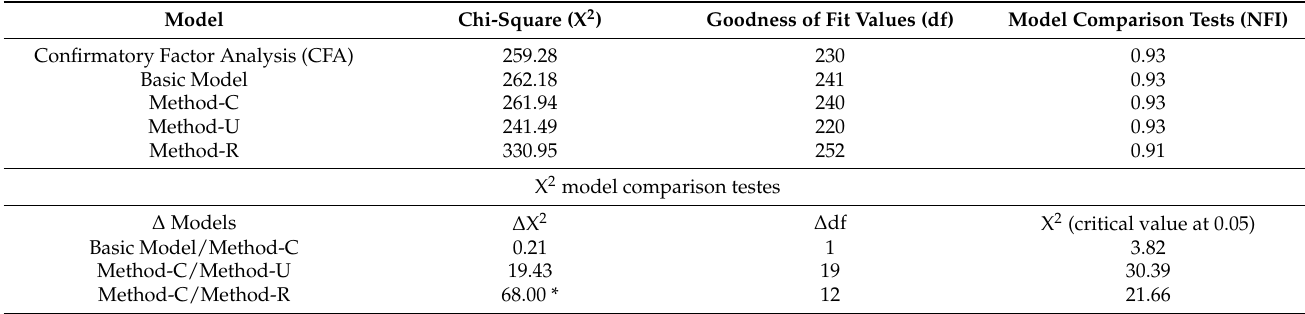
Table 4. Model comparison